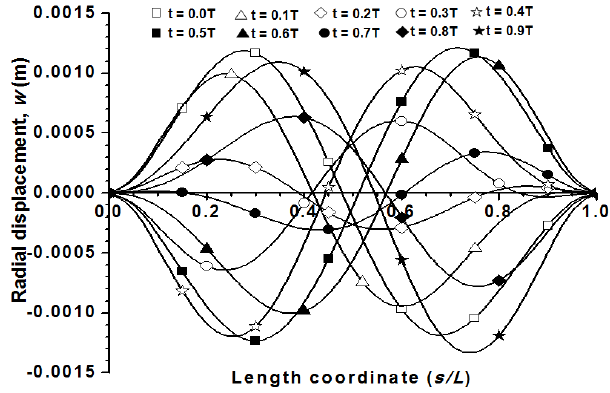
Figure 7: Variation of radial displacement along length at different time instants of a cycle. (excitation amplitude = 3.0 V).